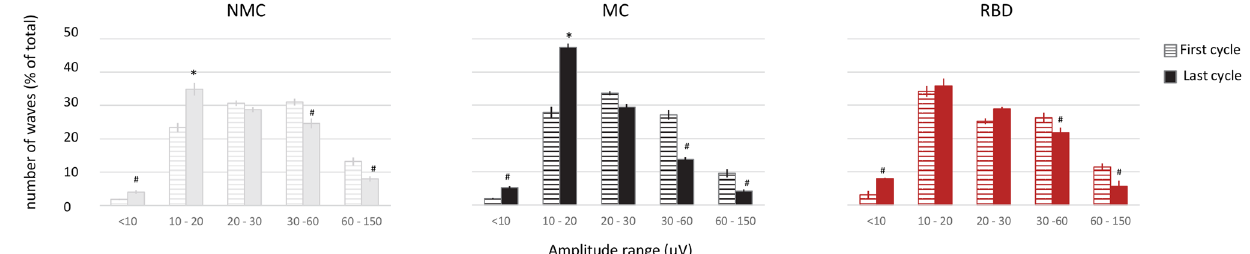
Figure 3. Distribution of the amplitude of slow waves during early and late NREM sleep. Proportion of slow waves in each amplitude range in early (first cycle, horizontal striped bars) and late sleep (last cycle, filled bars), in each group. Repeated-measure ANOVA with factors “time” (early—late) and “group” (RBD, NMC, MC) were performed for each amplitude bins. # indicate a significant ( p < 0.01) main effect of “time” and Bonferroni- corrected post-hoc tests *indicate an effect of “time” only in control groups (“group” × “time” p =